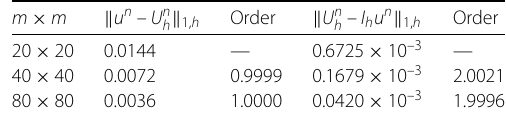
Table 3 Numerical results at t = 0.75 with τ = 5 h